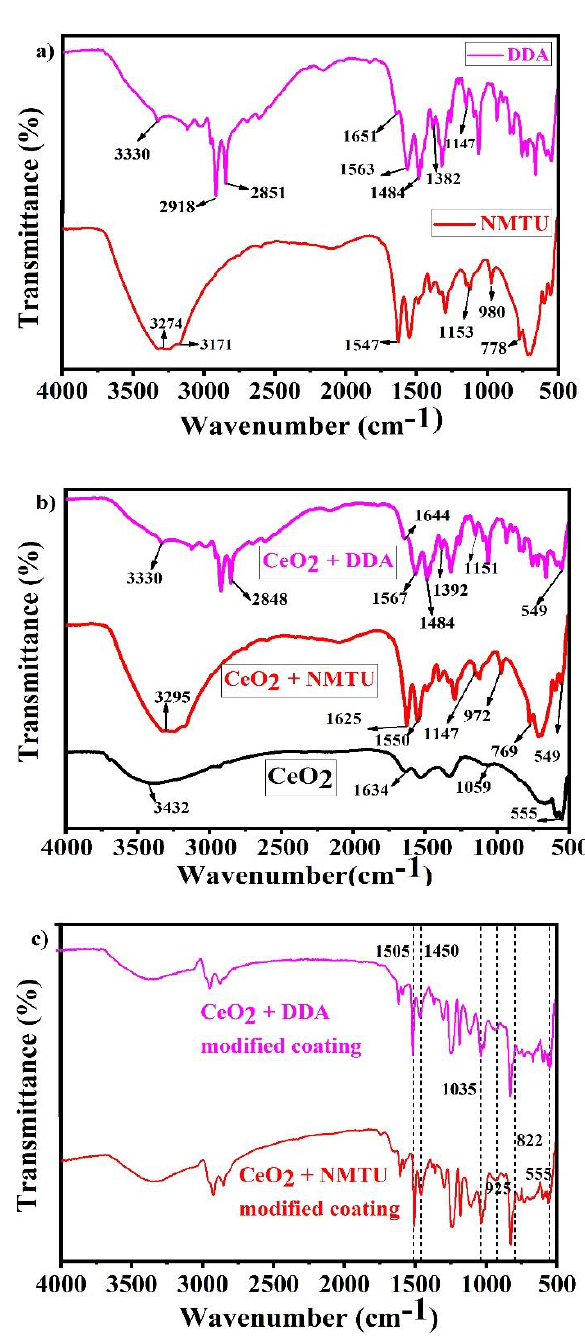
Figure 4. Fourier transform infrared (FTIR) spectra of ( a ) as-received inhibitors (NMTU and DDA), ( b ) unmodified and modified CeO 2 , and ( c ) nanocomposite smart coatings.